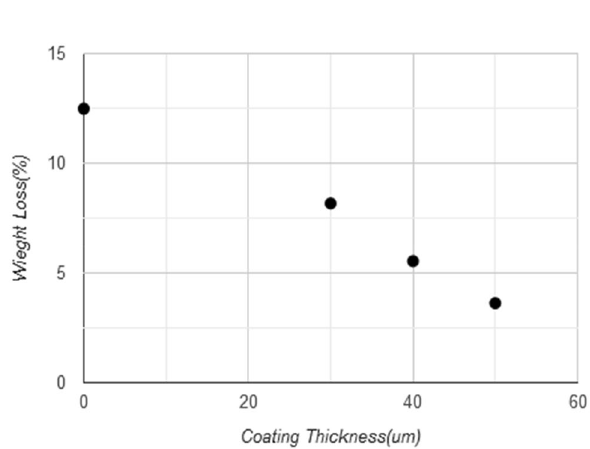
Figure 11. Weight loss ratio with coat thickness of samples inside elbow.